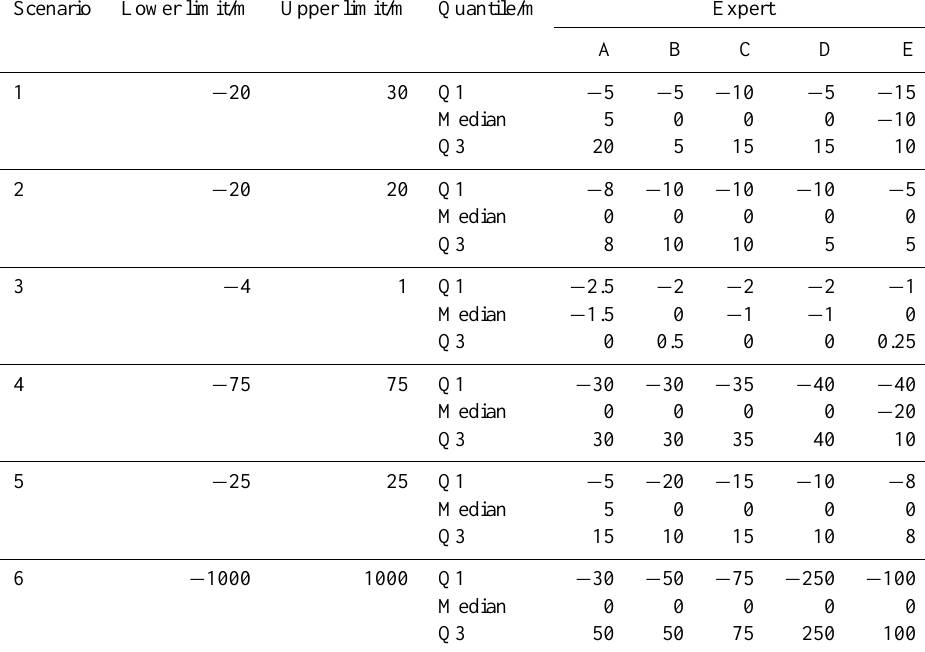
Table 1. Agreed plausible range and initial individual quantiles for boundary error distributions under each scenario.